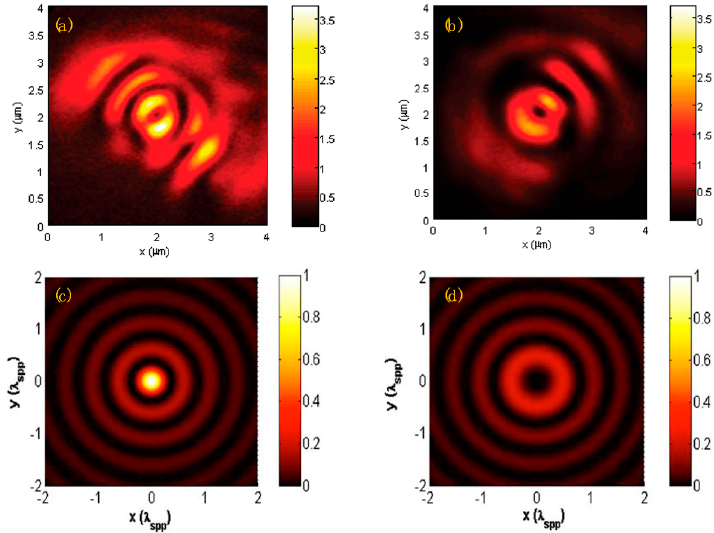
Figure 4. Measured near-field scanning optical microscope (NSOM) images at the air/gold interface ( a , b ); Reproduced with permission from [31], Copyright American Chemical Society, 2010. Analytical calculation surface intensity distribution ( c , d ); Reproduced with permission from [32], Copyright Optical Society of America, 2009. For an LHS lens structure under ( a , c ) RCP illumination and ( b , d ) LCP illumination.